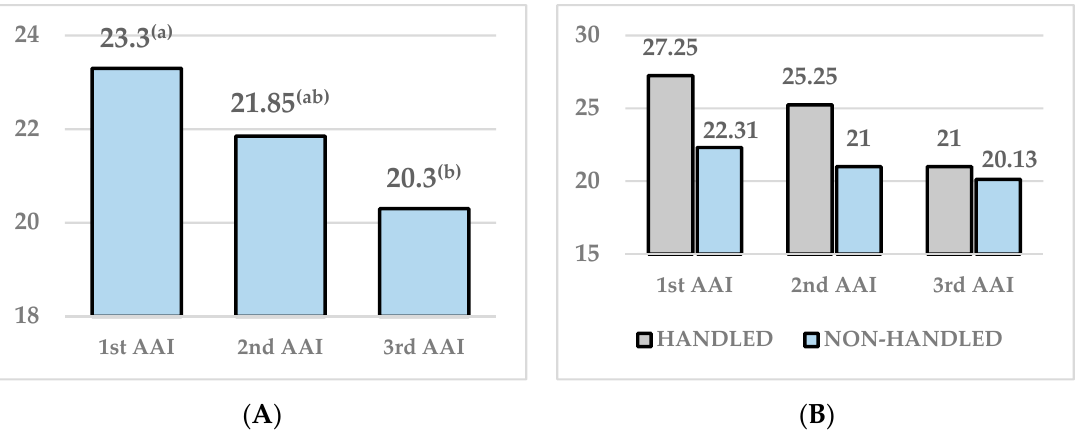
Figure 4. Children Approach Test results over the three sessions ( p = 0.02; difference was detected between the first and third AAI). ( A ) Total mean, ( B ) handled and non ‐ handled rabbits’ means. In ( A ), means with different letter marks significantly diverge from each other ( p < 0.05).